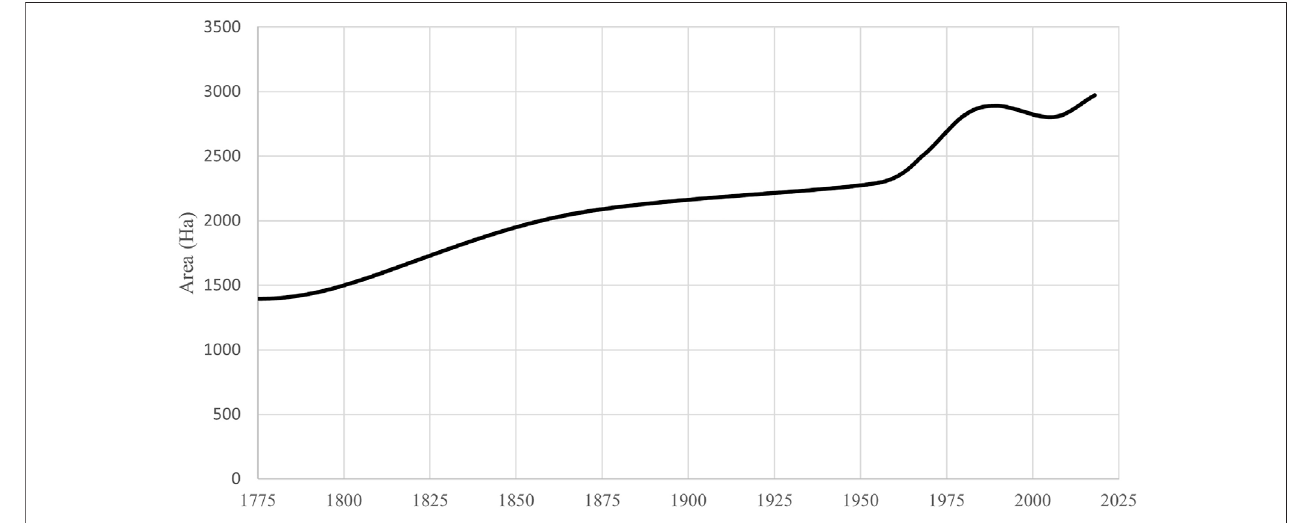
FIGURE 7 | Total area of Lake Mosti ș tea (south area).